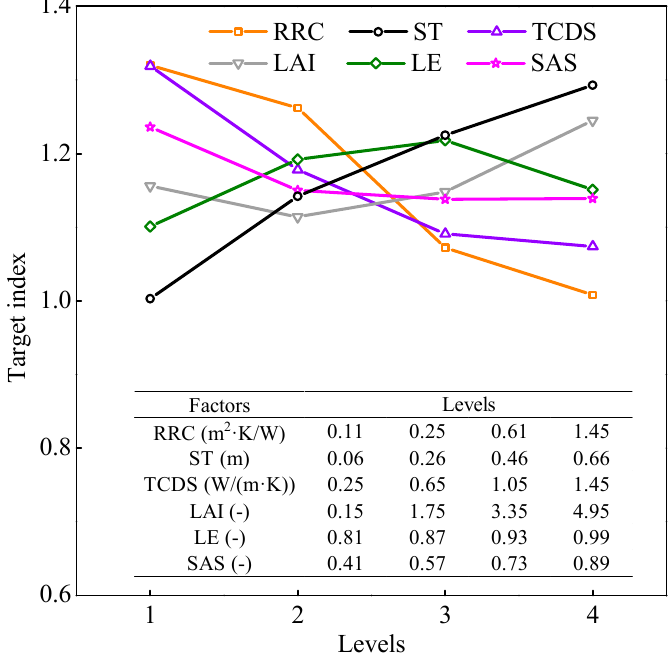
Figure 10. Main effect plots of the six factors. Figure 10. Main e ff ect plots of the six